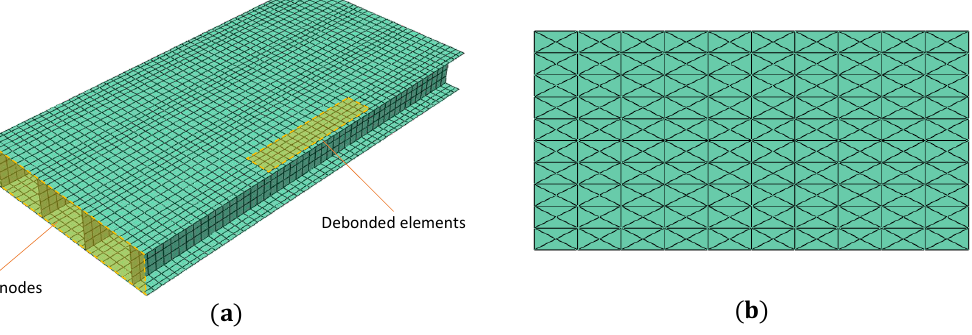
Figure 15. Element discretization for the ( a ) FE and inverse iFEM models, and ( b ) smoothing model of the wing box upper skin (10 × 10 SEA3